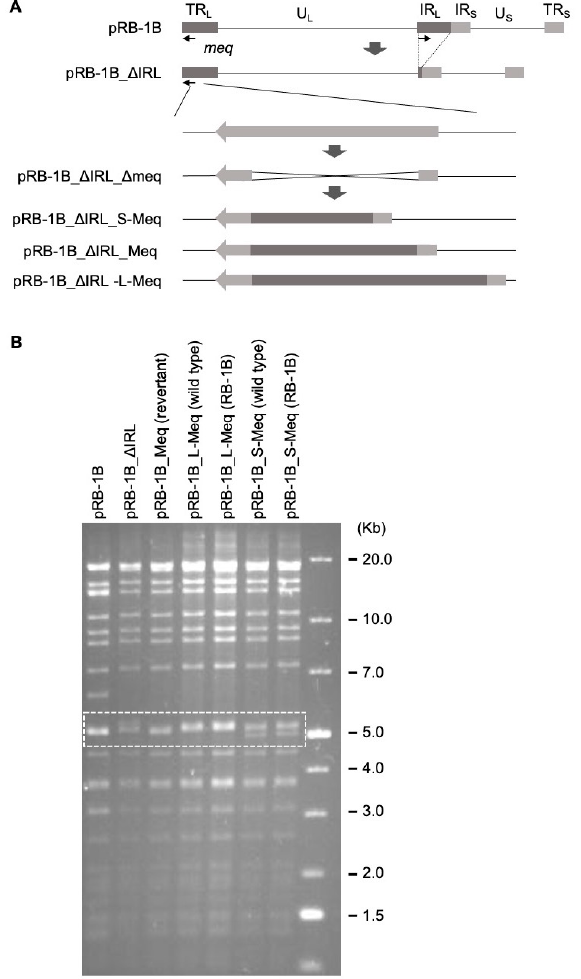
Figure 2. Construction of recombinant Marek’s disease viruses. ( A ) Schematic diagrams of the constructs cloned the RB-1B genome used in this study. In the RB-1B genome cloned as the bacterial artificial chromosome (BAC) plasmid (pRB-1B), most of the internal repeat long (IRL) regions were deleted, designated as pRB-1B_ Δ IRL, and used for mutagenesis. The meq gene in terminal repeat long (TRL) was replaced with the RB-1B- meq , short-Meq containing the deletion (S- meq ) (RB-1B), or long-Meq containing the insertion (L- meq ) (RB-1B) genes by two-step red-mediated mutagenesis. ( B ) Restriction fragment length polymorphism analysis of the BAC plasmids obtained by mutagenesis. The BAC plasmids were digested with BamHI to determine the accurate insertion of each meq -isoform into the RB-1B genome. A dashed box indicates the variation of the recombinant Marek’s disease virus genomes with each meq -isoform.